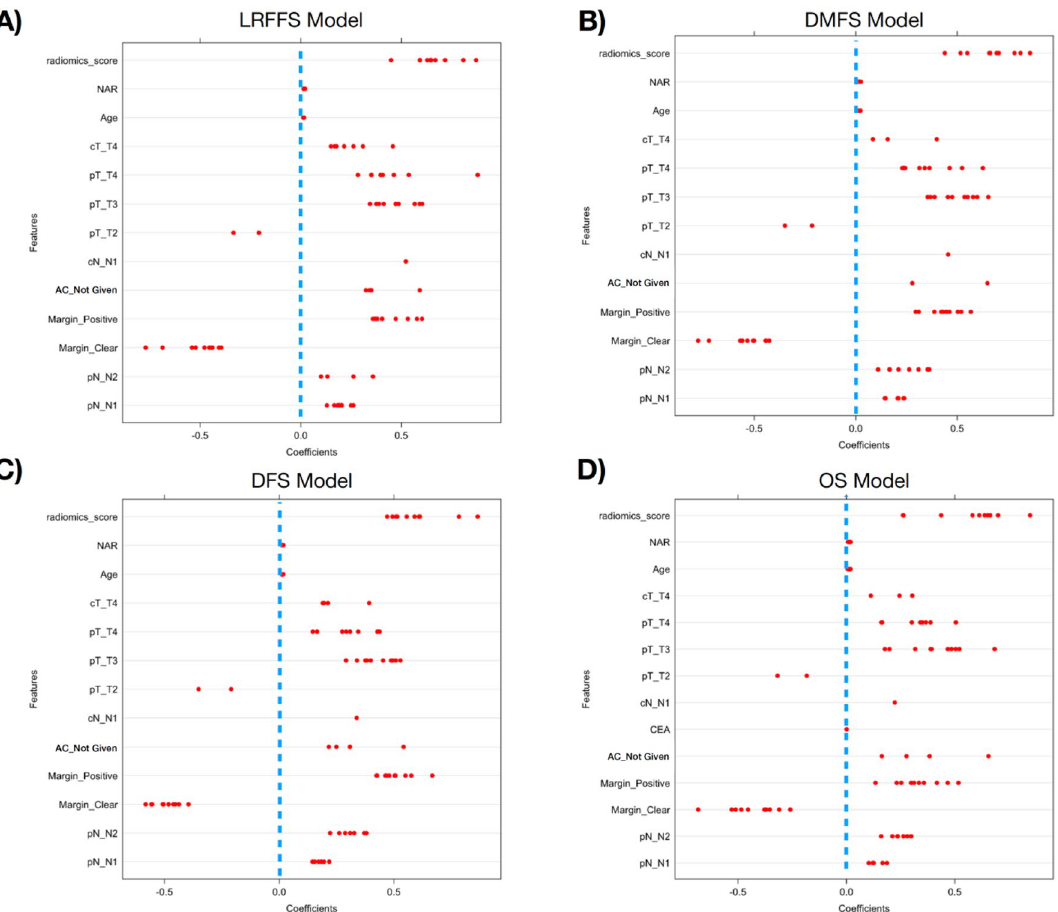
Figure 5. The coefficients of the combined ridge regression models for ( A ) LRFFS, ( B ) DMFS, ( C ) DFS and ( D ) OS for the 10 folds cross validations. Each red dot represents the coefficient of the feature in the model for a particular fold. The blue dotted line corresponds to coefficient